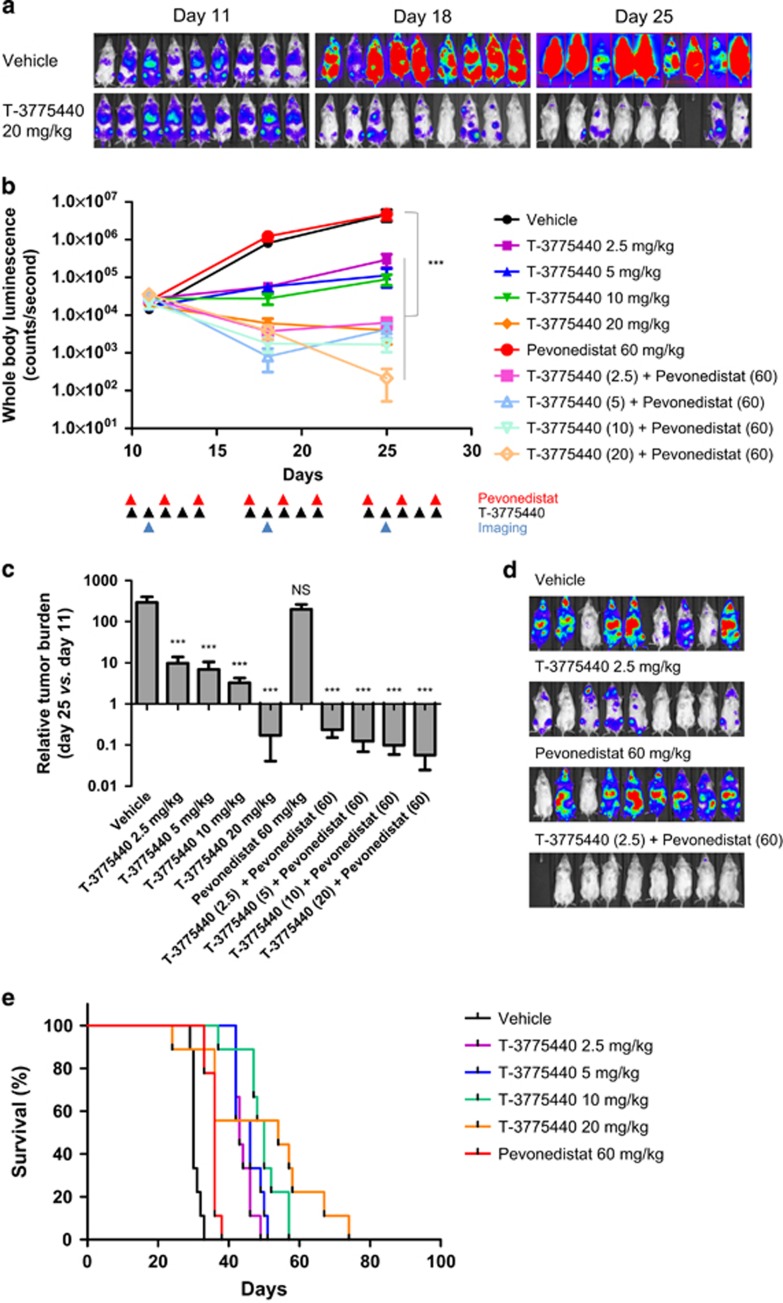
Coadministration of T-3775440/pevonedistat reduced leukemic burden and prolonged animal survival in an AML disseminated model. (a–f) Mice were inoculated via the tail vein with luciferase-labeled TF-1a cells (day 0). Mice were randomized into groups (n=9 per group) and treatment was initiated 10 days after cell injection (day 10). T-3775440 was administrated once daily (p.o.), and pevonedistat three times per week (days 1, 3 and 5, s.c.) according to the indicated dose and schedule. Tumor growth was monitored using an in vivo imaging system at days 11, 18 and 25. (a) Luminescence images of TF-1a-luc cell-bearing mice that received 20 mg/kg T-3775440 or vehicle are shown. (b) Whole-body luminescence of each treatment group is shown at the indicated time points. All values are means, and bars represent the s.e.m. (c) Bar charts showing relative tumor burden of each treatment group compared with that at days 11 and day 25. Means and s.e.m. are shown. Statistical significance was determined using Dunnett's multiple comparison test (***P<0.001). (d) Representative luminescence images (day 25). (e, f) Kaplan–Meier analysis was conducted to compare survival curves between vehicle-treated mice and T-3775440, MLN4924 or combination-treated mice. Single agent groups (e) and combination groups (f) are shown separately with the control group.